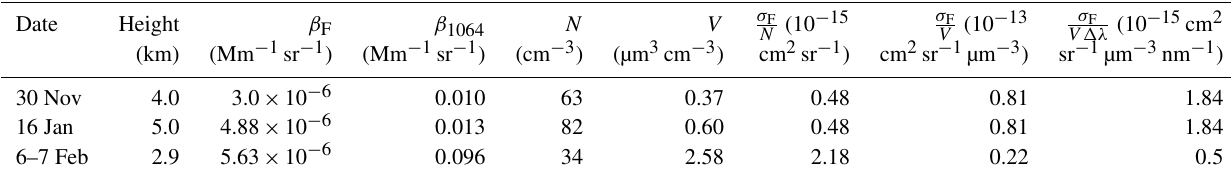
Table 2. The aerosol parameters in elevated layers for three measurement sessions from Fig. 3, including the fluorescence β F and aerosol β 1064 backscattering coefficients, number N and volume V particle densities, the differential fluorescence cross sections per single particle σ F and per unit of volume σ F , together with spectral density σ F N V V(cid:49)λ